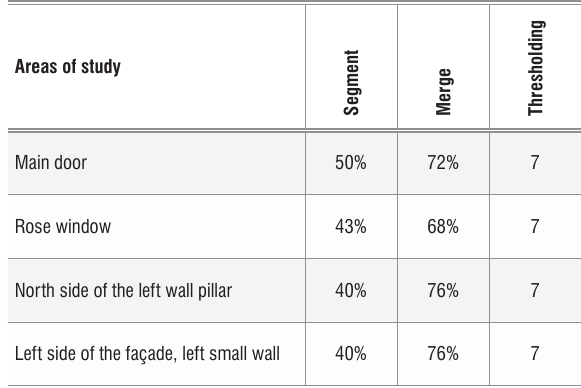
Table 1: Configuration parameters for segmentation in ENVI 4.7 software